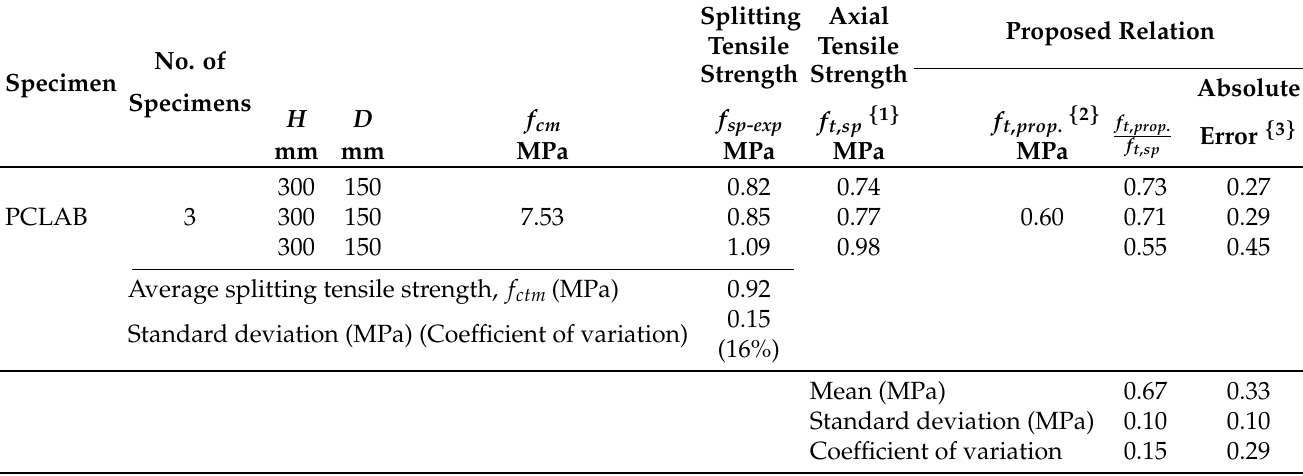
Table 7. Splitting tensile strength of the laboratory reproduced LPC specimens.